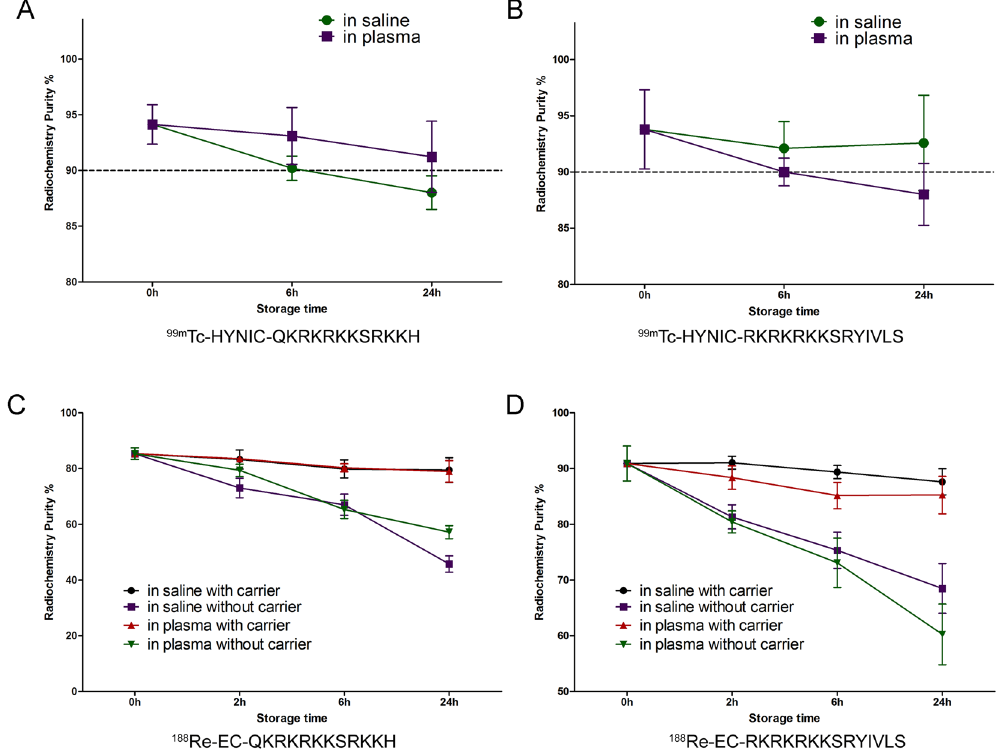
Figure 2. Stabilities of the 99m Tc-labeled and 188 Re-labeled peptides. The stabilities of the 99m Tc-labeled ( A , B ) and 188 Re-labeled peptides ( C , D ) were evaluated in saline and human plasma. The 99m Tc-labeled peptides maintained high stability in both solutions for 24 h. Ammonium perrhenate was used as a carrier, which increased the stability of the 188 Re-labeled